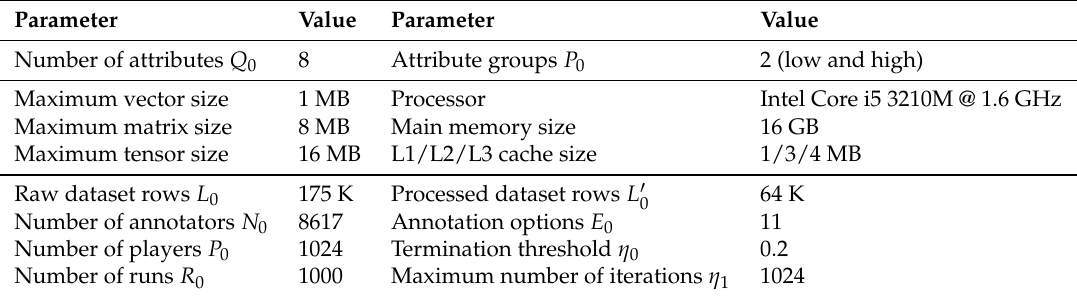
Table 8. Experimental setup (Source: